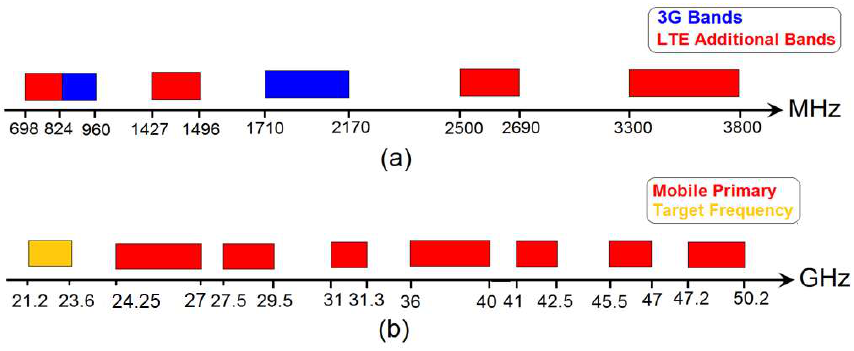
Figure 1. ( a ) Frequency spectra of 4G, ( b ) some candidate bands for 5G.